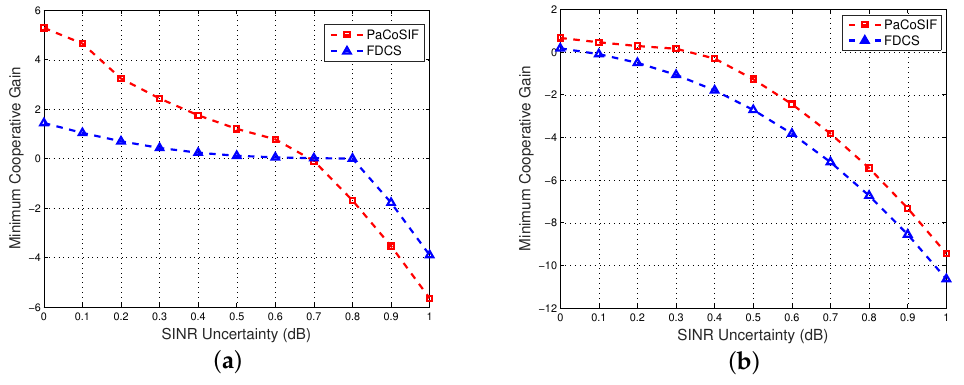
Figure 9. The impact of noise uncertainty upon the minimum cooperative gain. ( a ) ∆ ρ = 4 dB; ( b ) ∆ ρ = − 4